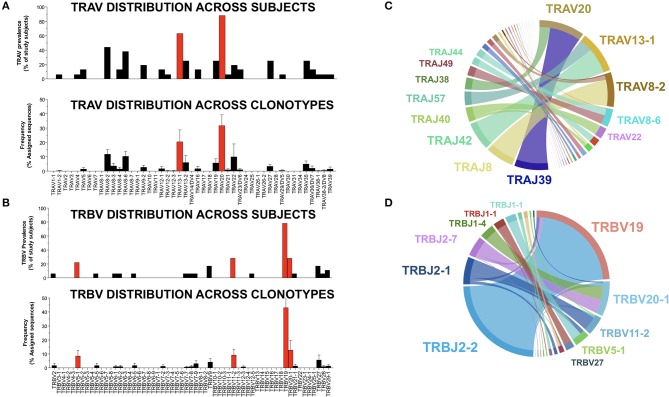
V and J gene usage in TCR-α and –β chain repertoires of HLA-B*44:03/NW8-specific CD8+ T cells. The distribution of TRAV genes (A) is shown (n = 16) individuals (top panel). The frequency of TRAV genes found in NW8-tetramer-sorted cells is expressed as a frequency of all assigned sequences (bottom panel). Individual bars indicate the mean frequency and standard error of the mean (SEM). Red bars indicate TRAV genes encoding TCR-α chains which are public. The distribution of TRBV genes (B) is shown (n = 18) individuals (top panel). The frequency of TRBV genes found in NW8-tetramer-sorted cells is expressed as a frequency of all assigned sequences (bottom panel). Individual bars indicate the mean frequency of a V gene and SEM. Red bars indicate TRBV genes encoding TCR-β chains which are public. TRAV-TRAJ co-occurrence maps are shown in (C), representative of 16 TCR-α repertoires. TRBV-TRBJ co-occurrence maps are shown in (D), representative of 18 TCR-β repertoires. The size of the arcs is proportional to TRAV, TRBV, TRAJ, or TRBJ frequency, the area joining any V-J pair is proportional to the frequency of that V-J pair. Co-occurrence maps were generated by VDJTOOLS as described in (30).